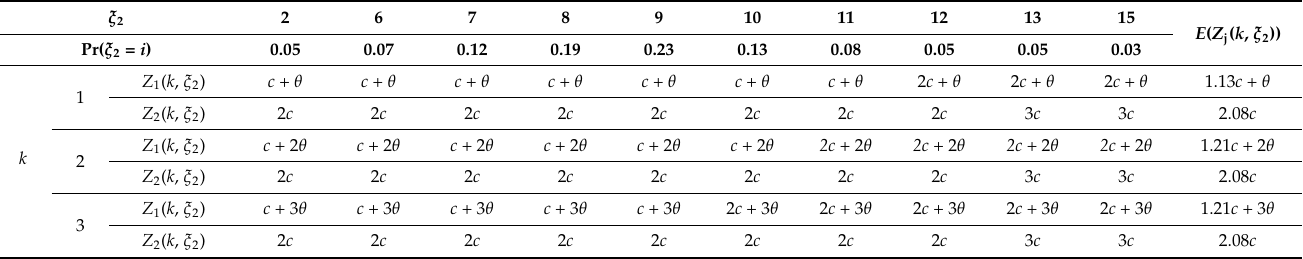
Table 8. Goods vehicle transport schedule of